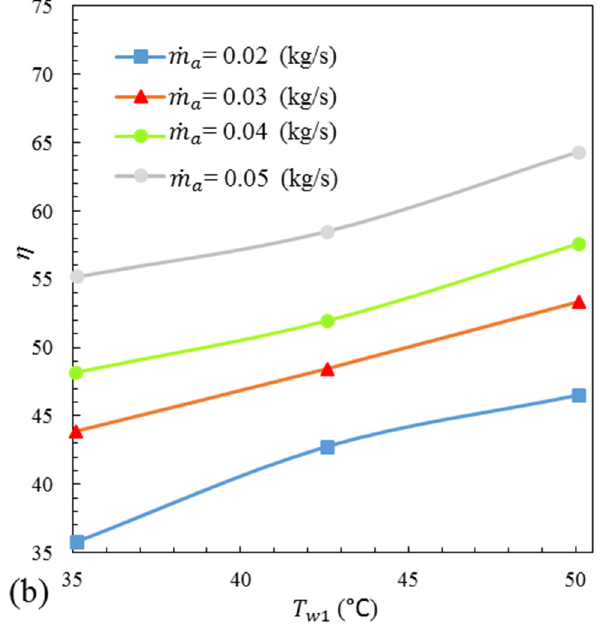
Figure 5. Cooling tower efficiency based on air flow rate at three different inlet water temperatures: ( a ) Efficiency versus air mass flow rate; ( b ) Efficiency versus inlet water temperature.